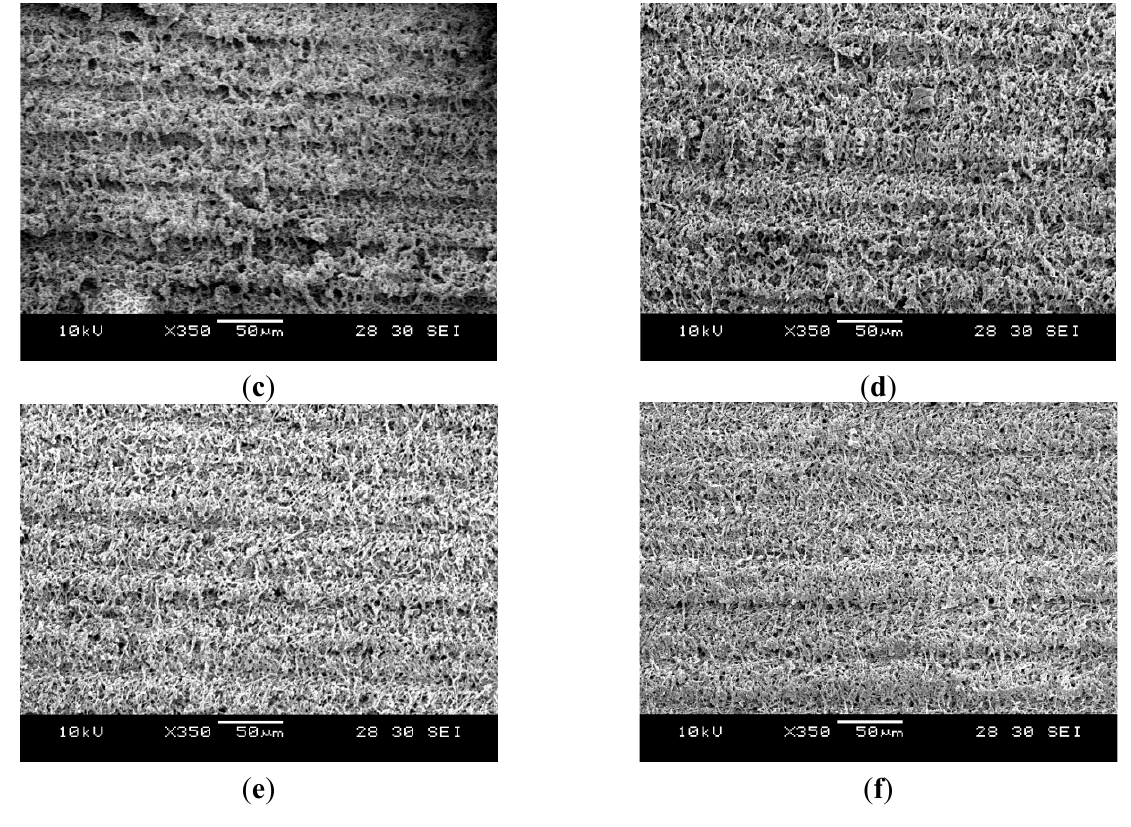
Figure 3. Scanning electron microscopy (SEM) images of surface morphologies at different PDRs with laser fluence fixed at 26.39 J/cm 2 . ( a ) Pristine COP surface; ( b ) PDR: 5.57 W/mm 2 ; ( c ) PDR: 2.79 W/mm 2 ; ( d ) PDR: 1.39 W/mm 2 ; ( e ) PDR: 0.93 W/mm 2 ; ( f ) PDR: 0.7 W/mm 2 .